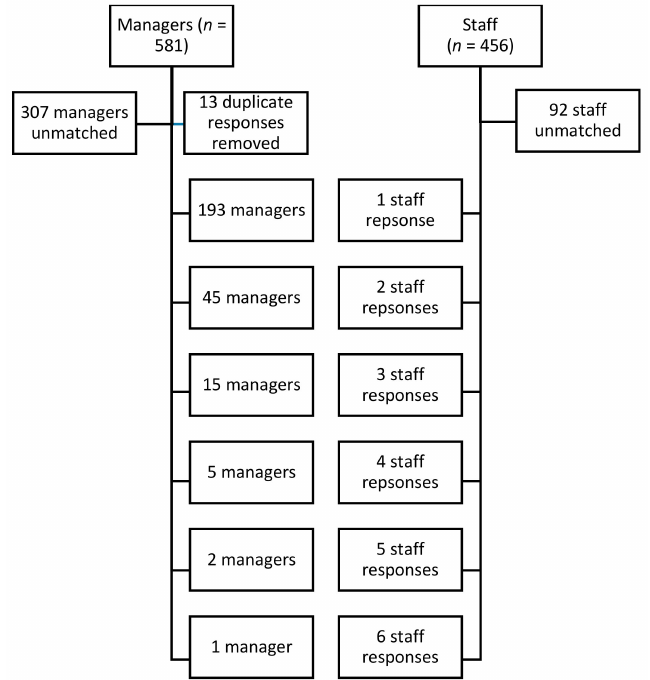
Figure 1. Breakdown of matched manager and sta ff responses by